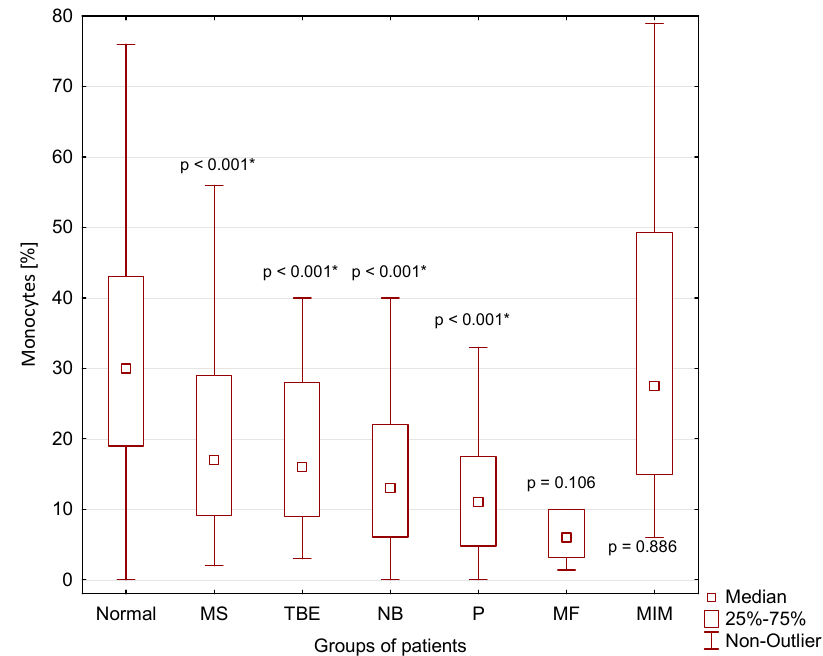
Figure 5. Percentage of neutrophils in CSF in our patient groups (*: statistically significant). A significantly lower percentage of monocytes in CSF compared to normal CSF findings was found in CSF of patients with MS ( p < 0.001), TBE ( p < 0.001), NB ( p < 0.001) and P ( p < 0.001) (Figure 6).